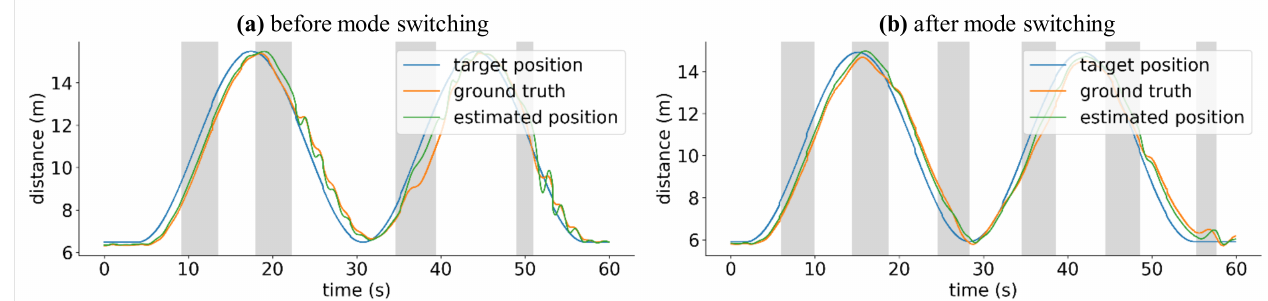
Figure 9. Mode switching results.